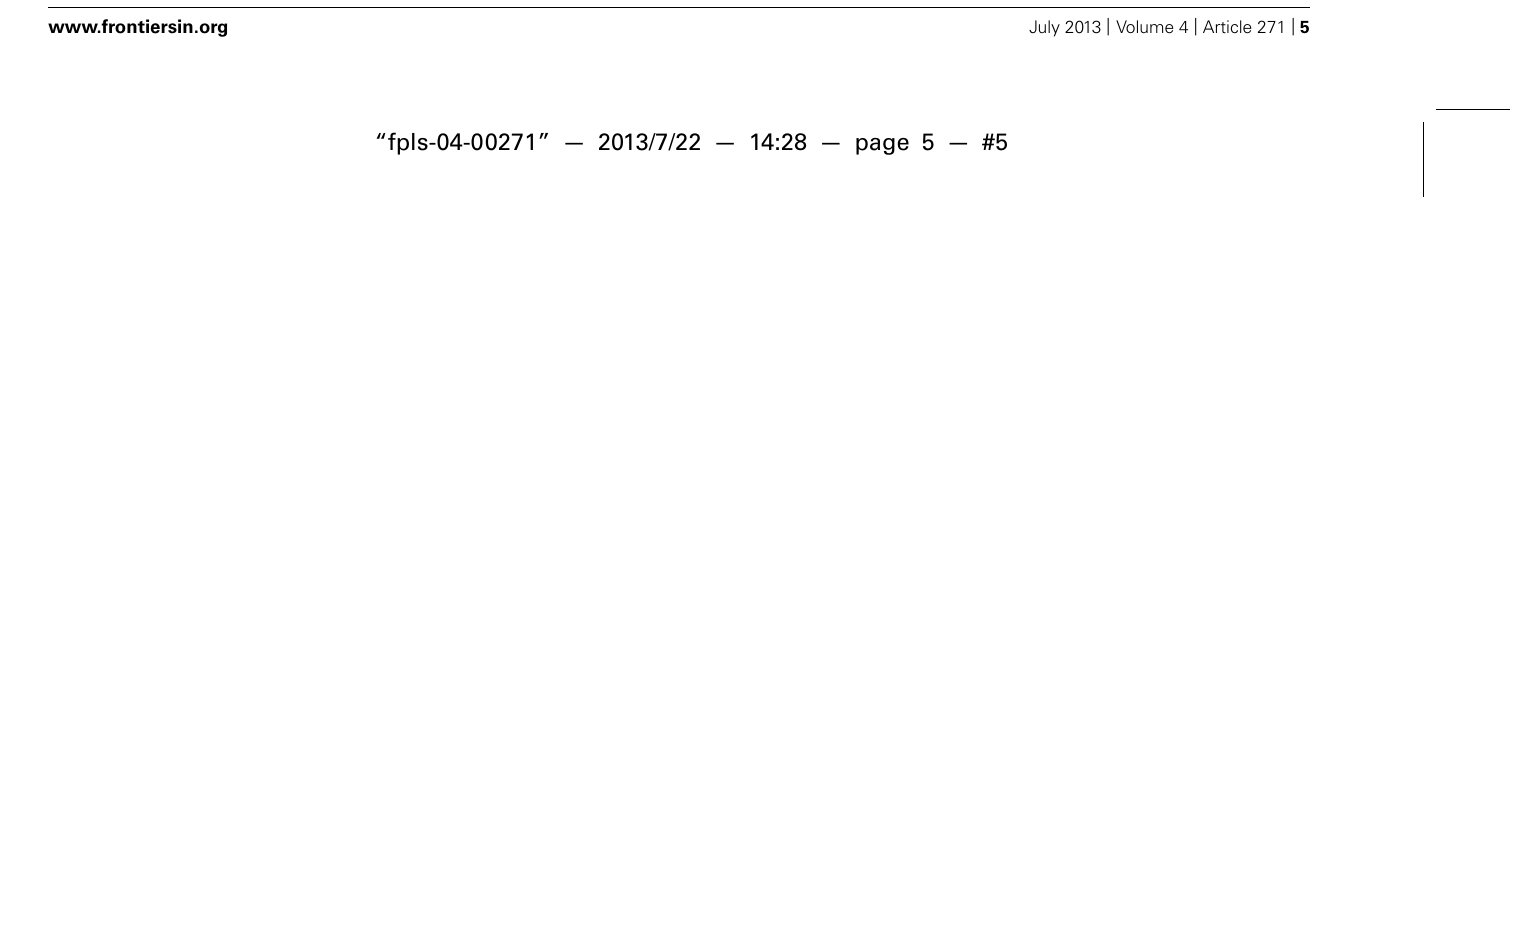
FIGURE 3 | Salt-washed plant ribosomes support cap-dependent and cap-independent translation in ribosome-depletedWGL. (A) Map of 5 (cid:2) UTR-Fluc-3661 and Cap-Rluc-A reporter constructs. 5 (cid:2) UTR- Fluc-3661 contains the firefly luciferase ORF flanked by theTCV 5 (cid:2) UTR and positions 3661–4054. Cap-Rluc-A contains a capped, polyadenylated renilla luciferase ORF. (B) In vitro translation of 3 (cid:2) UTR-Fluc-3661 using ribosome-depletedWGL supplemented with eitherWGL ribosomes or